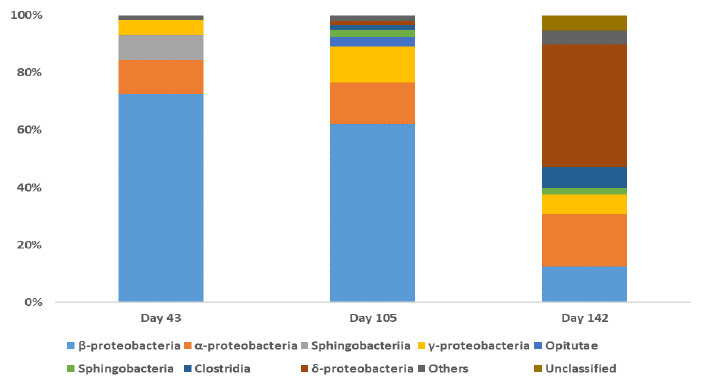
Figure 3. Community analysis of the class-level bacteria present during the BDE-209 biodegradation in the clay/water slurry system.